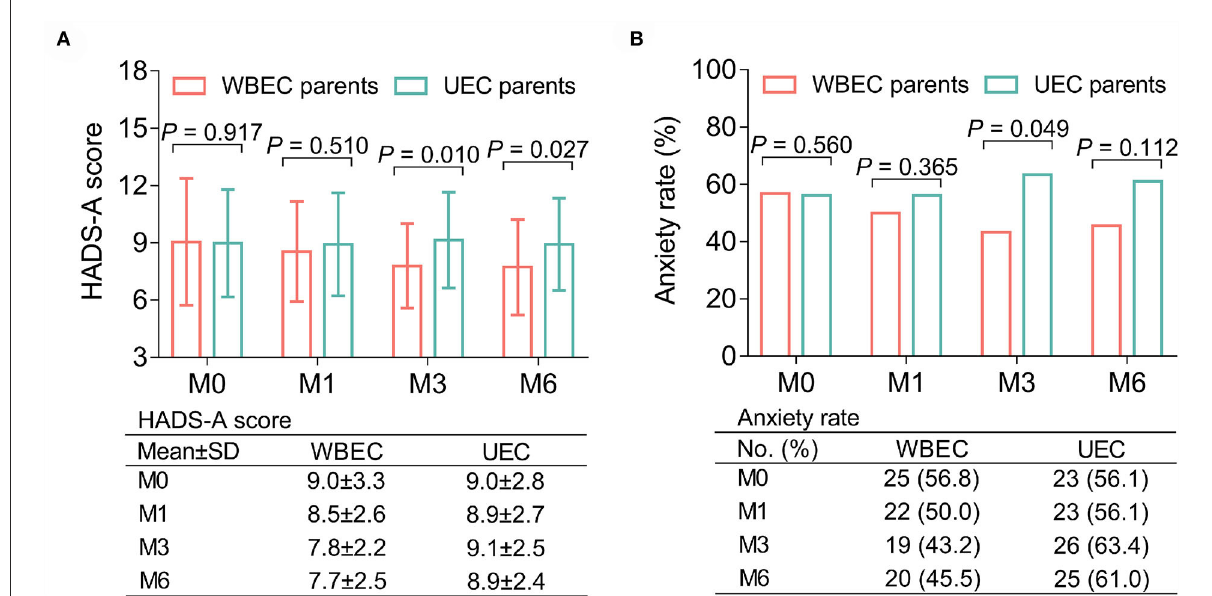
FIGURE2 Effect of WBEC on anxiety in parents of pediatric and adolescent patients with osteosarcoma. Comparison of HADS-A score (A) and anxiety rate (B) at M0, M1, M3, and M6 between parents in WBEC group and UEC group. WBEC, WeChat-platform-based education and care program; UEC, usual education and care program; HADS-A, Hospital Anxiety and Depression Scale for anxiety; M, month.